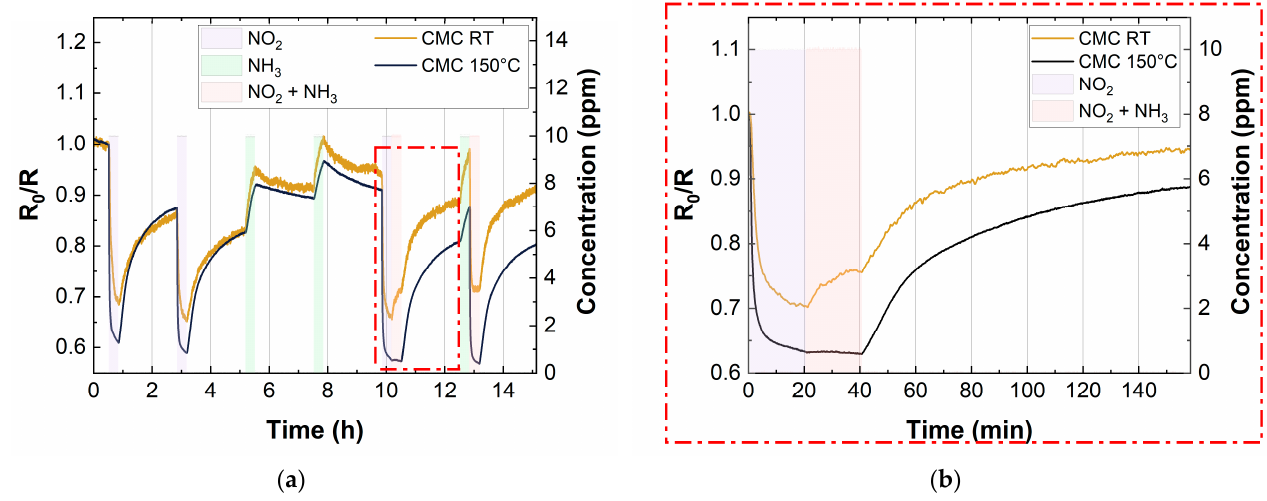
Figure 12. ( a ) Cross-sensitivity of 10 layers CMC-based sensor with 10 ppm NO ₂ and 10 ppm NH ₃ at RT (yellow curve) and 150 °C (blue curve); ( b ) magnification that shows the increase in selectivity of SWCNT-based gas sensors vs. NO 2 at 150 °C.